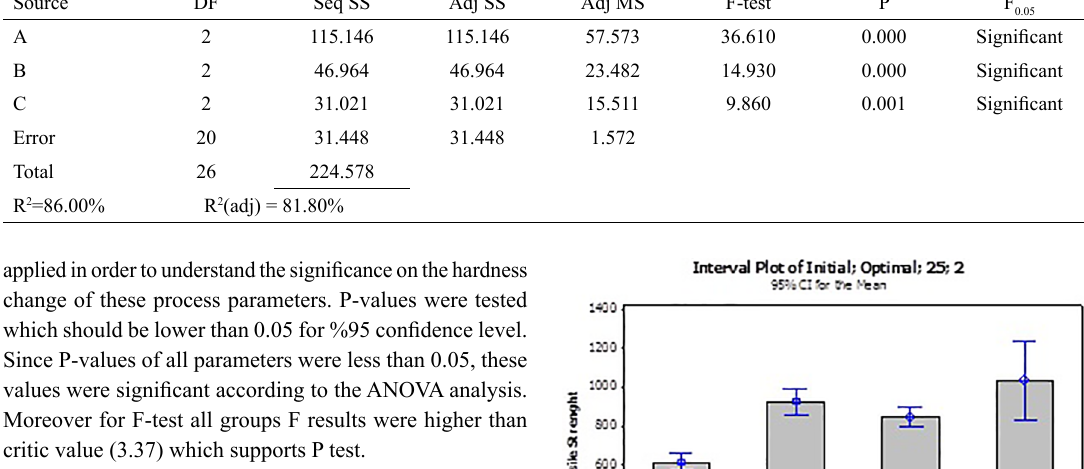
Table 3. ANOVA results for hardness homogeneity of specimens manufactured with experimental design parameter Source